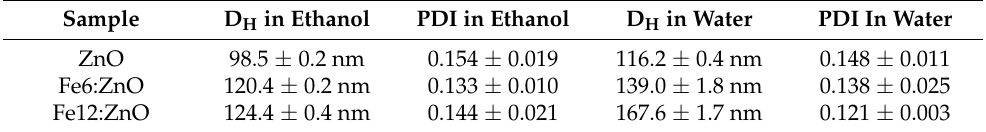
Table 5. Dynamic light scattering results for Fe:ZnO NPs. The hydrodynamic diameter (D H ) and the polydispersity index (PDI) are expressed as mean values ± standard deviation of three